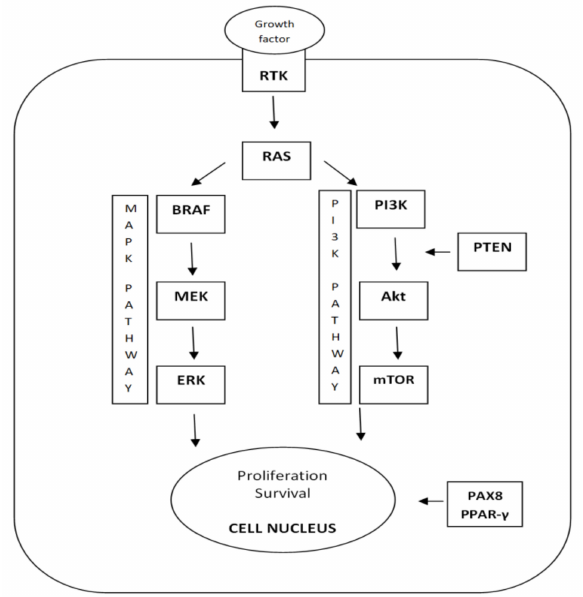
Figure 1. Simlified scheme of cell signaling pathways important in thyroid cancerogenesis (RTK— growth factor receptortyrosine kinase; RAS, BRAF, MEK, ERK, PI3K—signal molecules; Akt— protein kinase B; mTOR—mechanistic target of rapamycin; PTEN—phosphatase and tensin homolog; PAX8/PPAR- γ —fusion